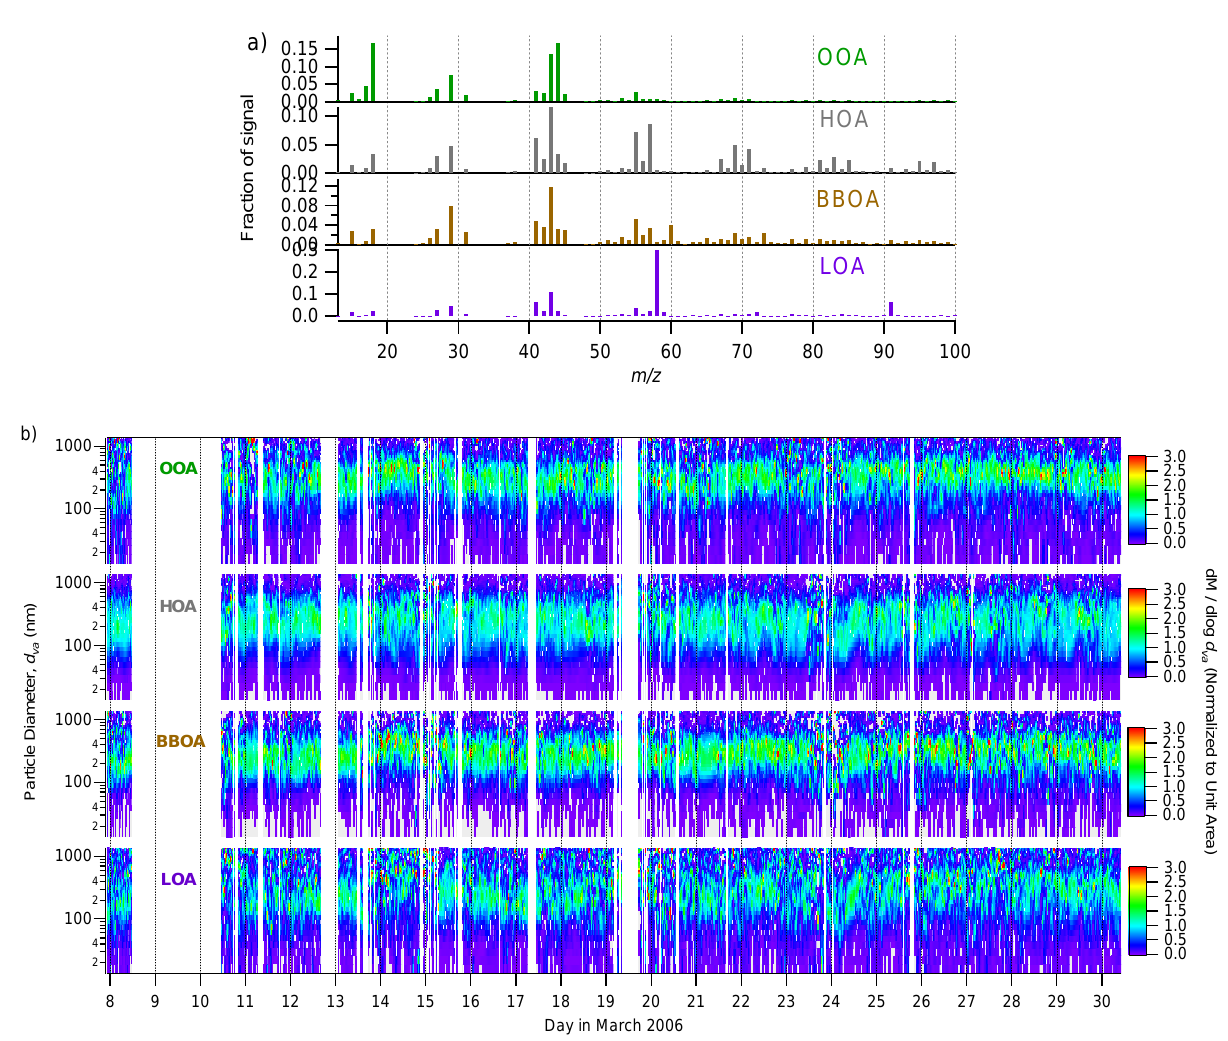
Fig. 7. The best constrained vector-matrix solution, which has four factors. Four a priori mass spectra were provided as starting guesses: OOA, HOA, and BBOA from the HR-MS solution, and LOA from the best solution of the 3-vector model (Fig. 4). The a priori spectra were allowed to vary with β =0.06, as described in Eq. (6). (a) Mass spectrum of each factor, normalized to sum to 1. (b) Mass size distribution (d M /dlog d va ), normalized so that each size distribution has unit area. The factor size distributions have been binomially smoothed by one point each in time and size for improved visual clarity. Light-grey pixels have zero